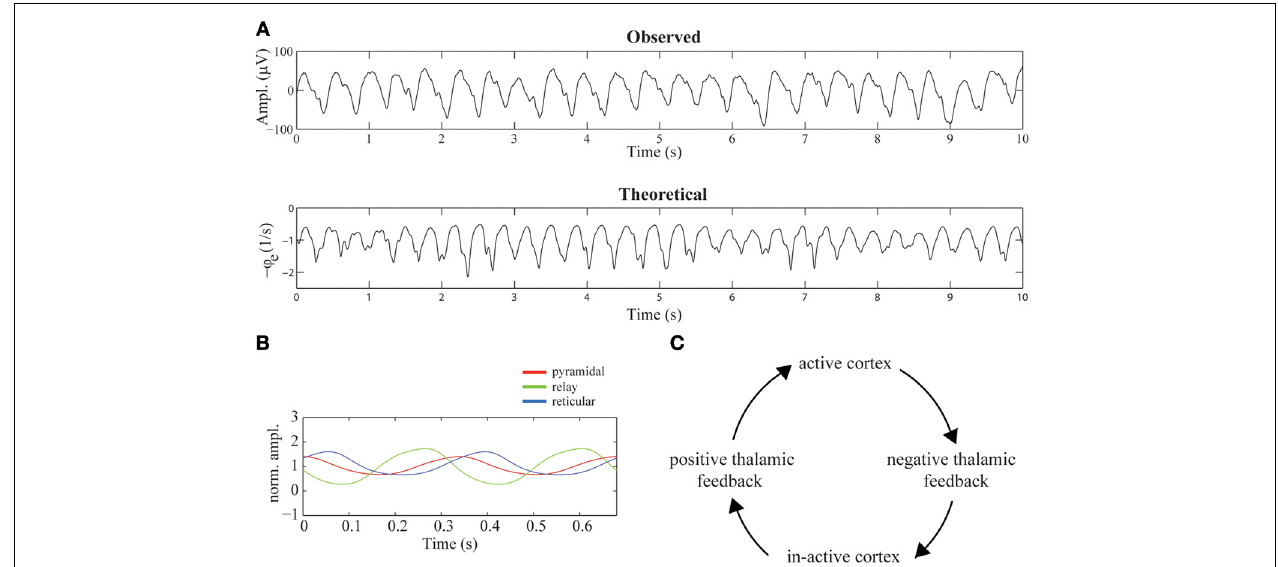
FIGURE 4 | Mechanism suggested to underly diffuse rhythmic delta activity. (A) 10-s epochs of recorded (top-row) and simulated (bottom-row) EEG time-series. The simulated time-series were generated using the parameter values listed in Table 1 . (B) The firing rates of cortical pyramidal neurons (red), thalamo-cortical relay neurons (green), and thalamic reticular